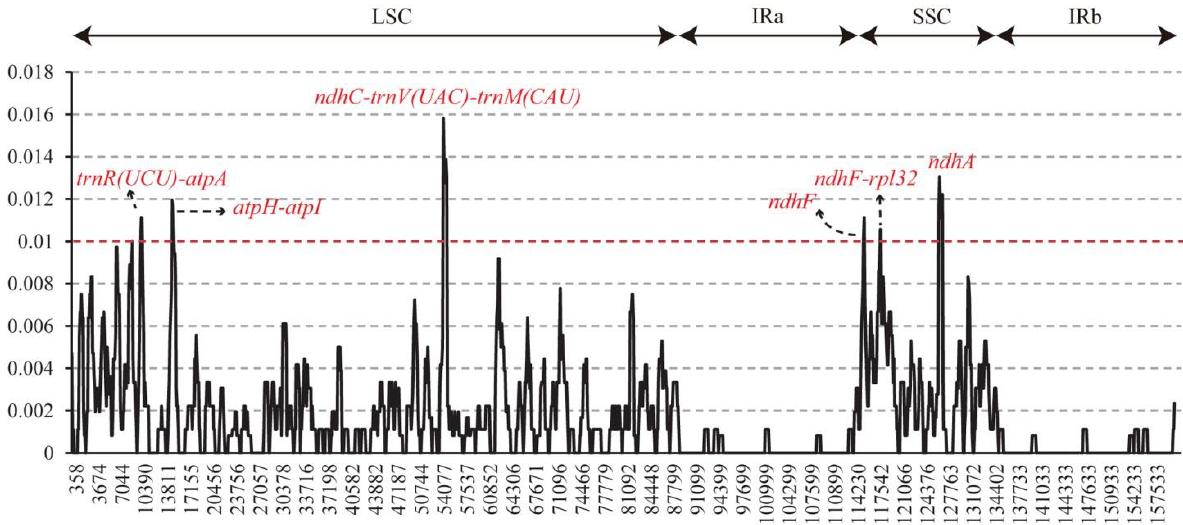
Figure 5. Sliding window analysis of the whole plastomes of four Crataegus species. x -axis shows the position of the midpoint of each window; y -axis shows value of nucleotide diversity in a sliding window analysis of window size 600 bp with step size 100 bp.